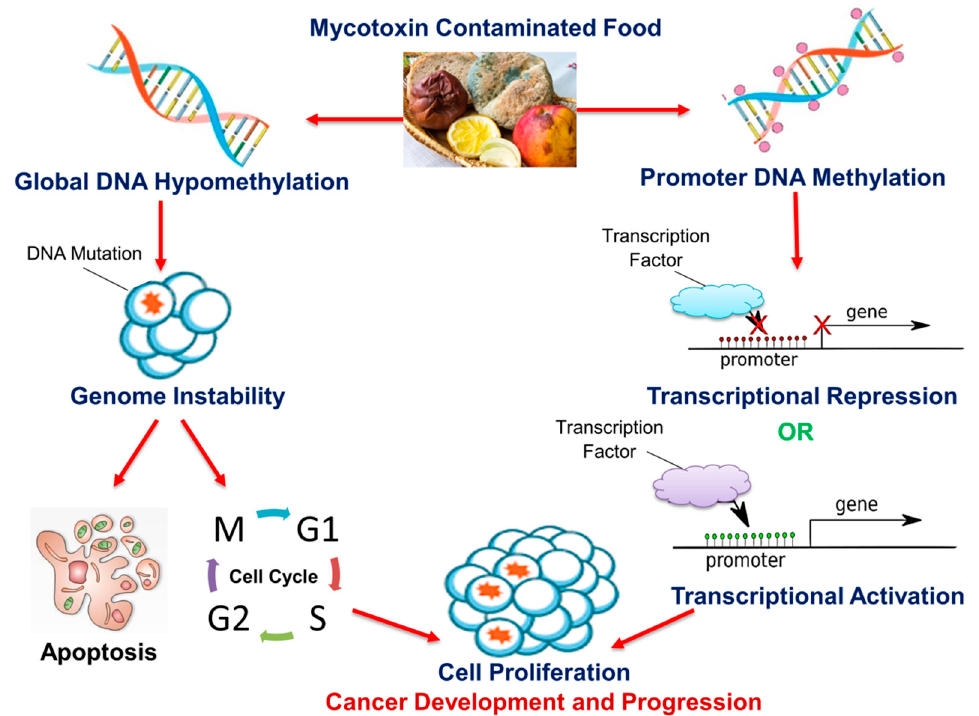
Figure 5. The effect of mycotoxins on DNA methylation and cancer. Mycotoxins can alter global DNA methylation and/or promoter DNA methylation in various cells both in vitro and in vivo. Global DNA hypomethylation leads to genome instability and increases the frequency of DNA mutations. Mutated cells are destroyed via apoptosis or evade cell cycle regulatory checkpoints and proliferate, leading to cancer development and progression. Promoter DNA methylation contributes to carcinogenesis via the transcriptional repression of tumor suppressor genes and/or transcriptional activation of oncogenes.